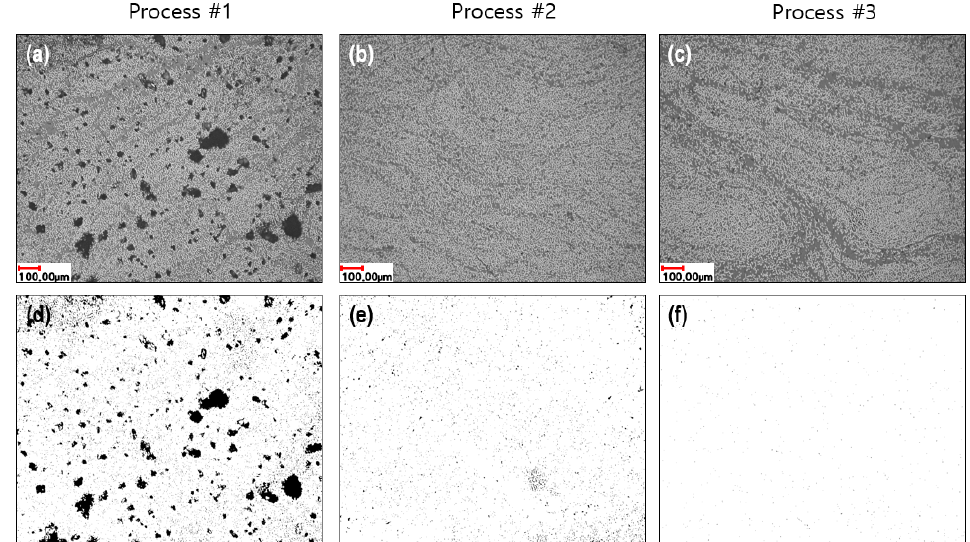
Figure 7. Cross-section image observed by optical microscope for process ( a ) #1, ( b ), #2, and ( c ) #3 and void fraction analysis for process ( d ) #1, ( e ), #2, and ( f ) #3.